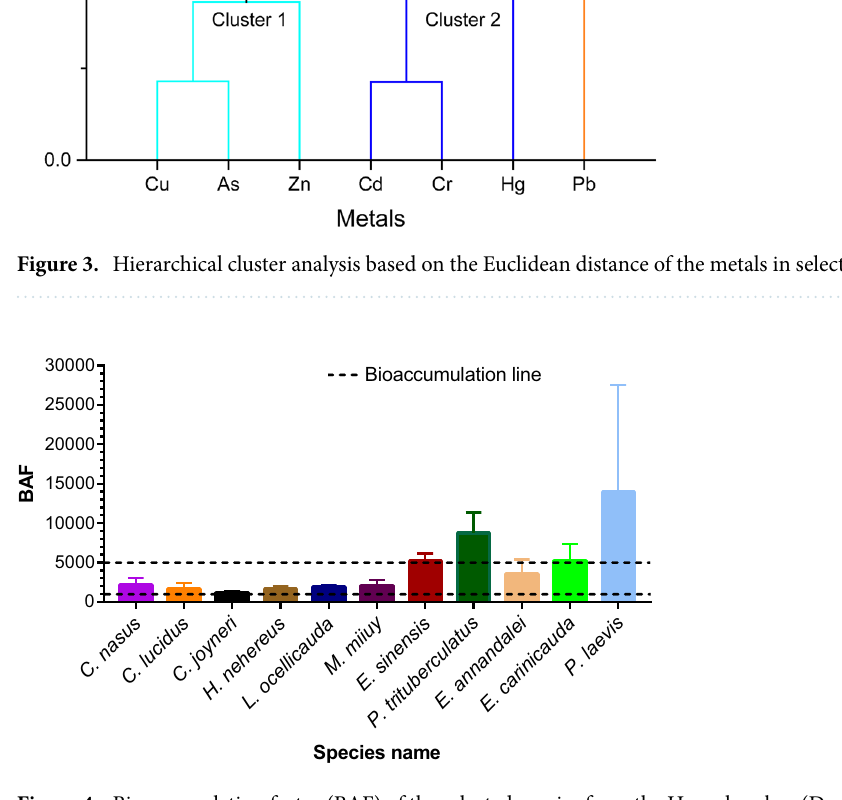
Figure 4. Bioaccumulation factor (BAF) of the selected species from the Hangzhou bay (Dashed line indicates the Bioaccumulation